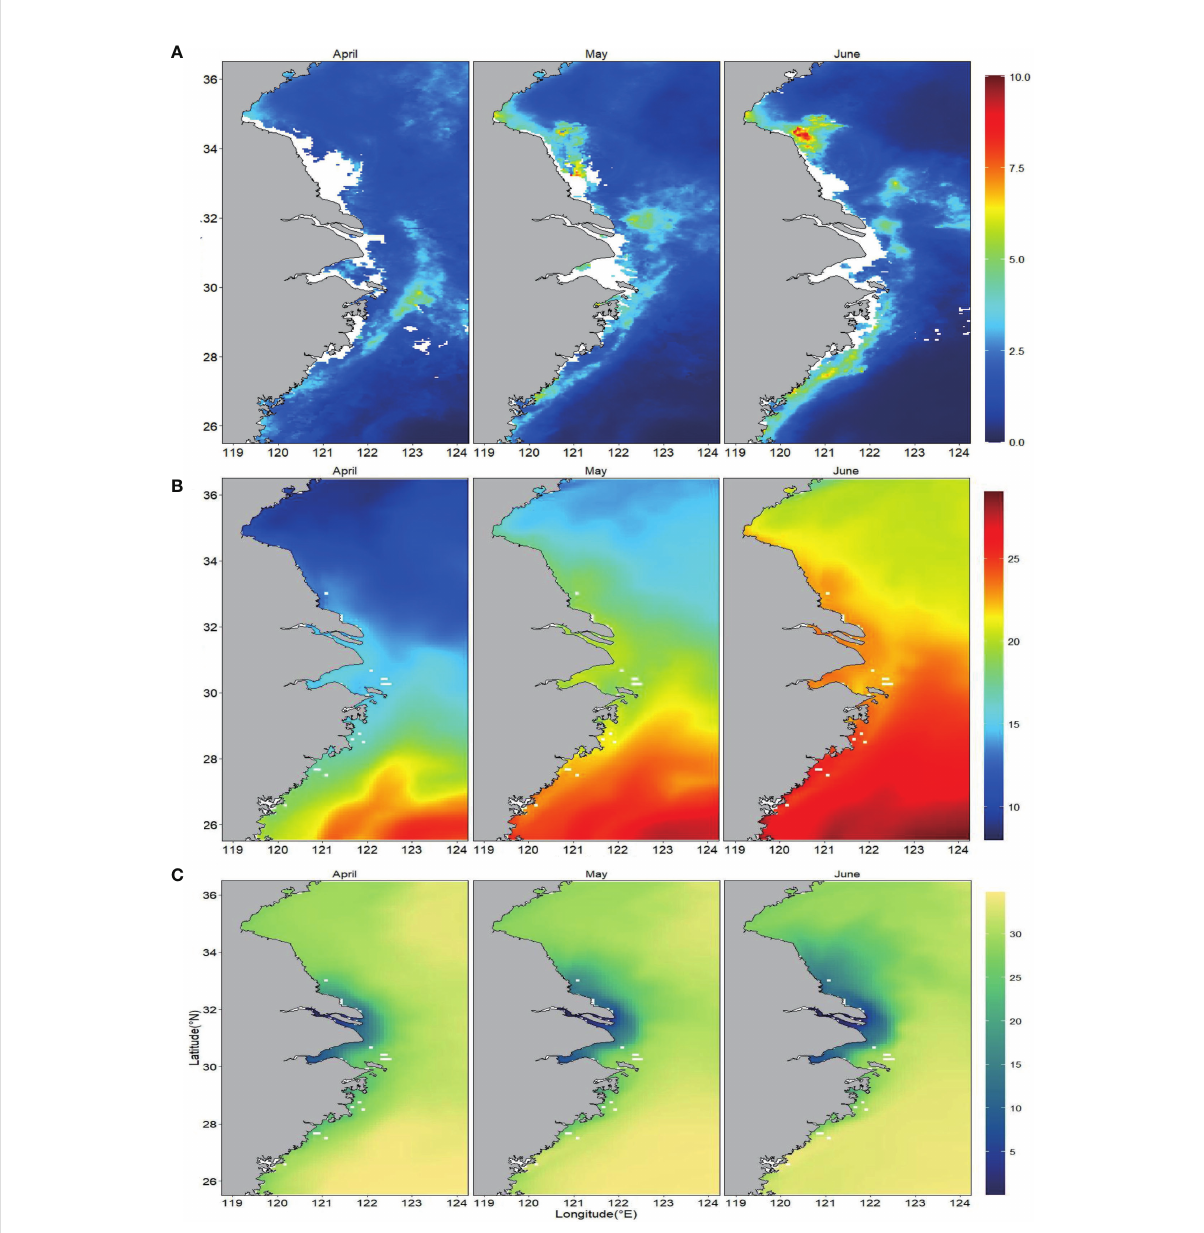
FIGURE 2 Monthly means of (A) chlorophyll-a (Chl-a), (B) sea surface temperature (SST), and (C) sea surface salinity (SSS) from April to June from 2015 to